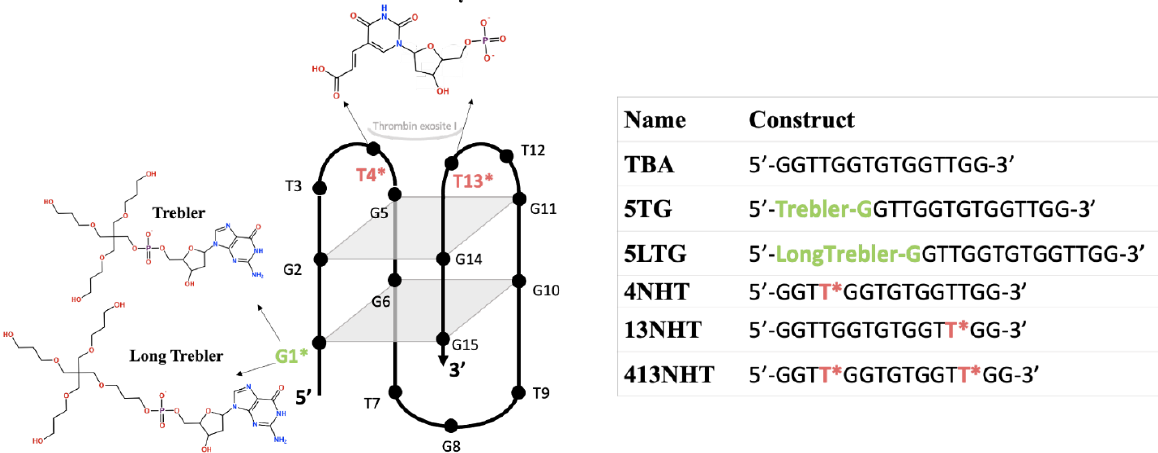
Figure 1. Modifications introduced in the thrombin binding aptamer and the different constructs used in this study.